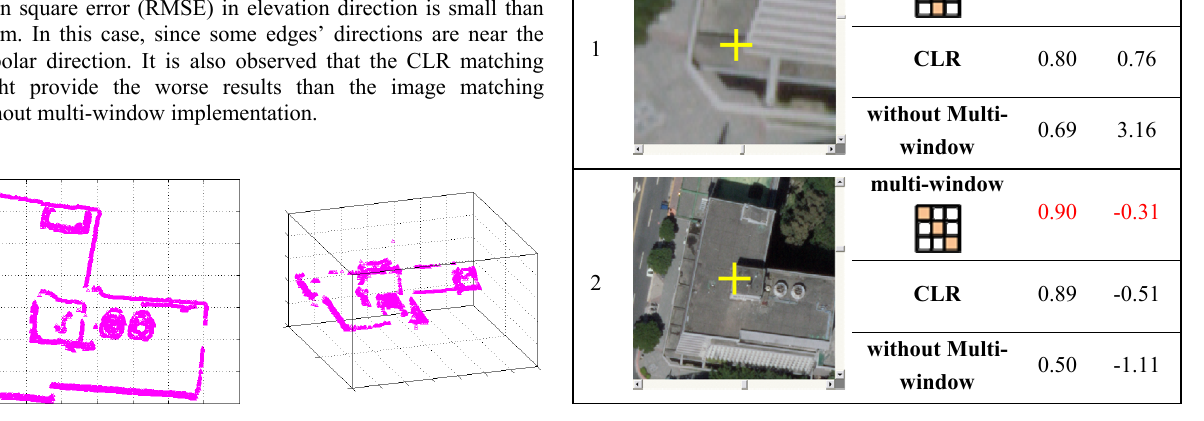
Figure 5. Results of 3D Coordinates by Multi-window